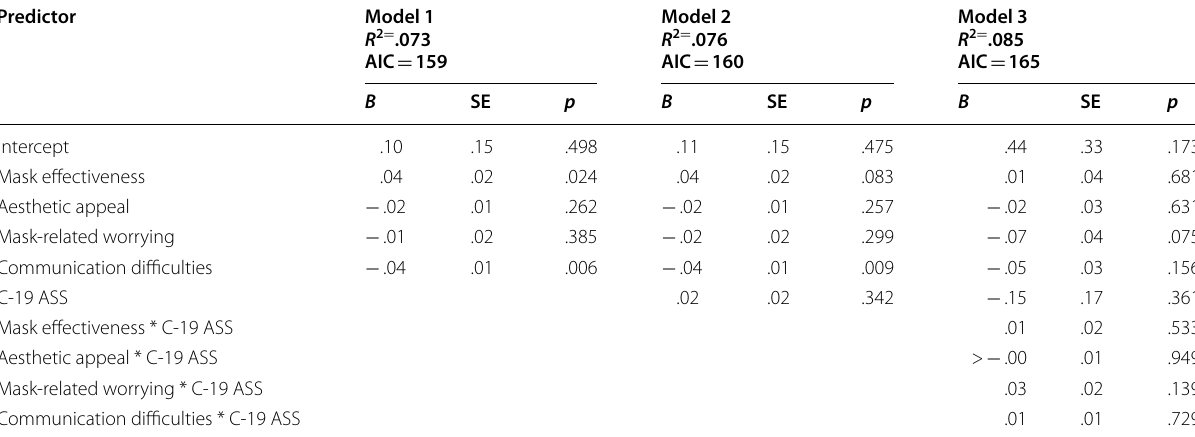
Table 3 Stepwise general linear model with implicit evaluation of (masked) faces (BIAT d-scores) as outcome